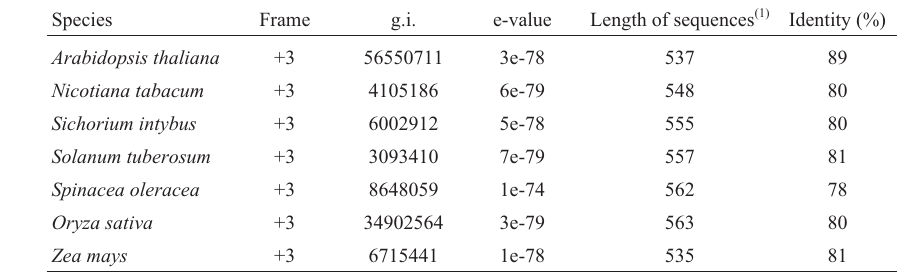
Table 4 - Translation frames for the nucleotide sequence of cluster EGEQST1002B11.g, e-values, amino acid sequence lengths corresponding to the enzyme protoporphyrinogen IX oxidase (E.C. 1.3.3.4), and identity percentages in relation to the cluster, for different higher plant species.